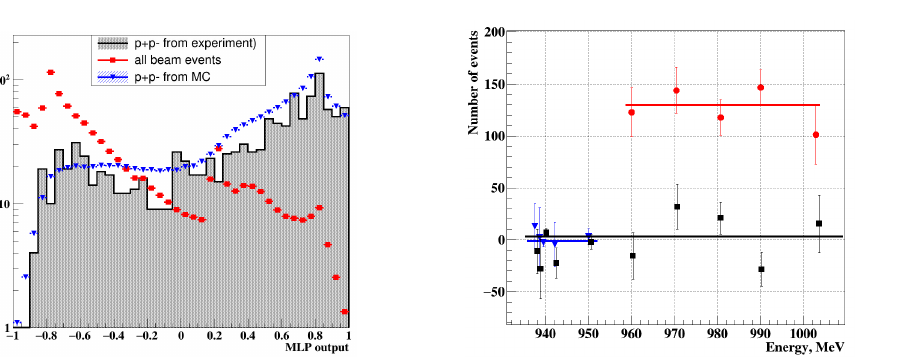
Figure 5: MLP output for p ¯ p and back- ground events.